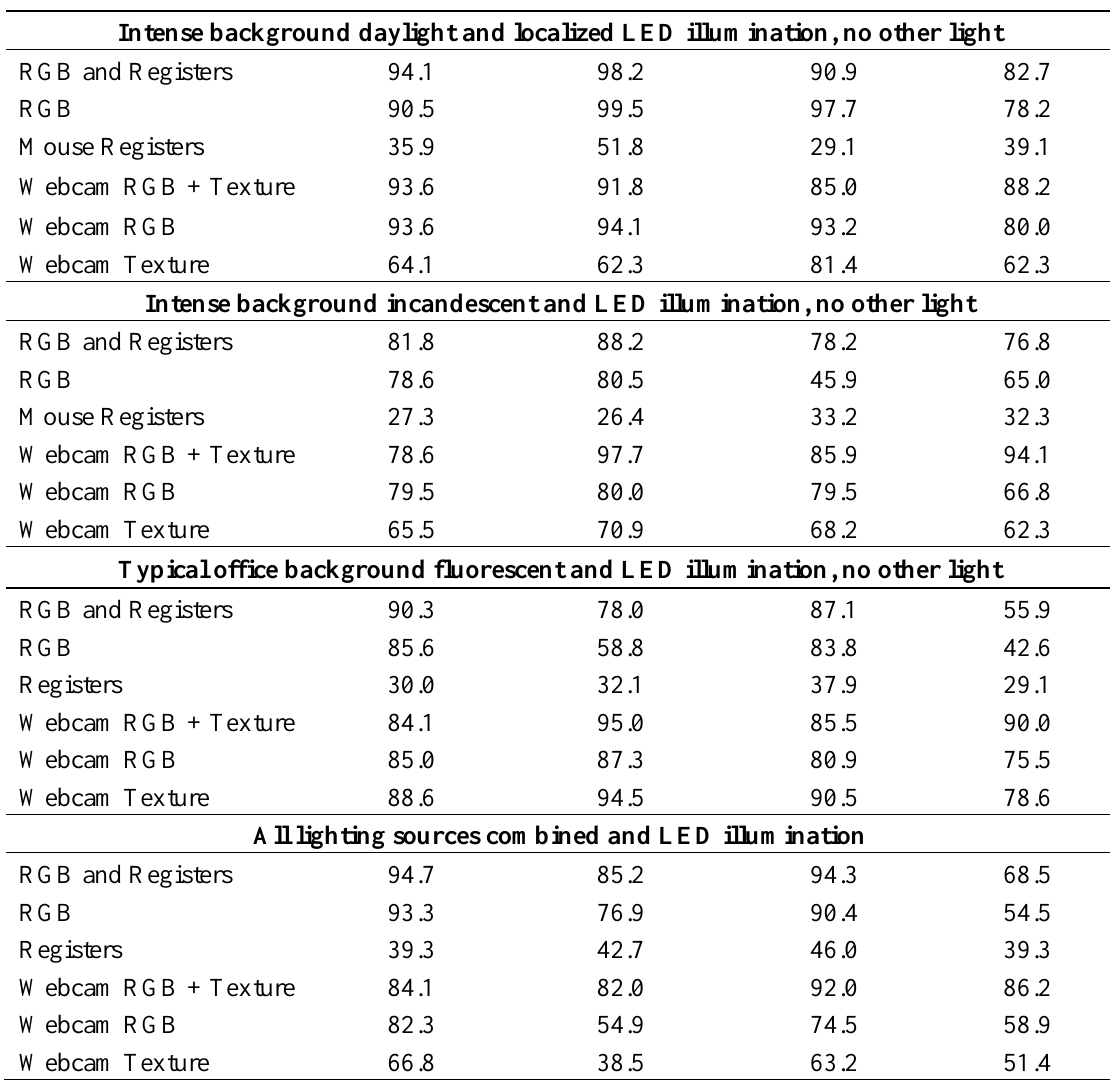
Table 3. Background lighting test